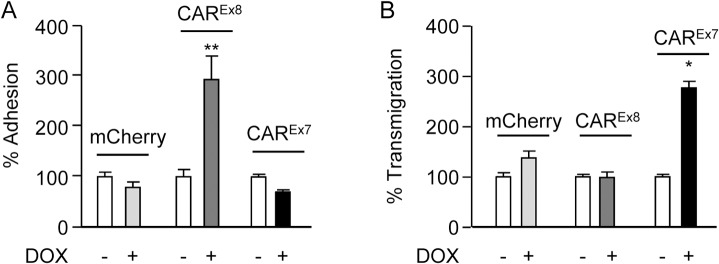
Apical CAREx8 protein expression increases apical adhesion of infiltrating neutrophils.Neutrophil transmigration assays were performed in the basal-to-apical direction in MDCK stable cells exposed to the neutrophil chemoattractive peptide fMLP on the apical surface. A) % neutrophil adhesion and B) % neutrophil transmigration were quantitated by measuring the fluorescence intensity of fluorescently-labeled neutrophils imaged by fluorescence microscopy. Error bars represent the SEM from three independent experiments; *p < 0.05 or **p < 0.01 by one-way ANOVA.